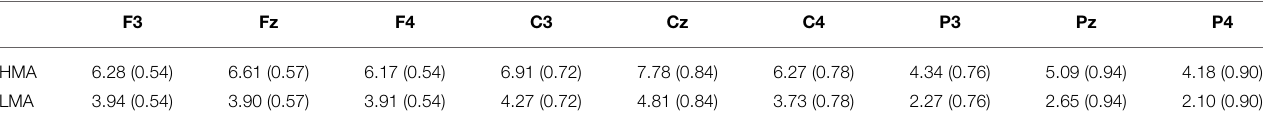
TABLE 2 | Mean amplitudes (in µ V) and standard error (in brackets) for the P2 component in the calculation phase (175–225ms) for the HMA and LMA groups. F3 Fz F4 C3 Cz C4 P3 Pz P4 HMA 6.28 (0.54) 6.61 (0.57) 6.17 (0.54) LMA 3.94